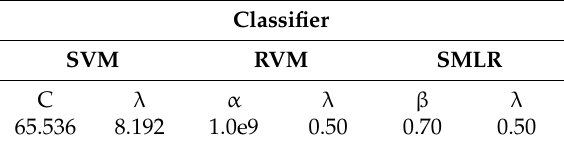
Figure 3. Location of the classes in the three-dimensional feature space of the dataset selected. Table 1. User-defined parameters with ATM data using different classifiers.